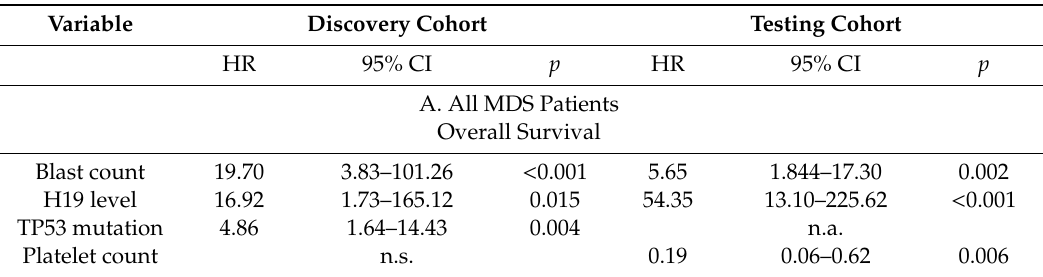
Table 2. Multivariate Cox-regression analysis of the overall survival and progression-free survival of MDS patients. Only the variables that remained significant after backward variable selection are listed and sorted according to their descending p